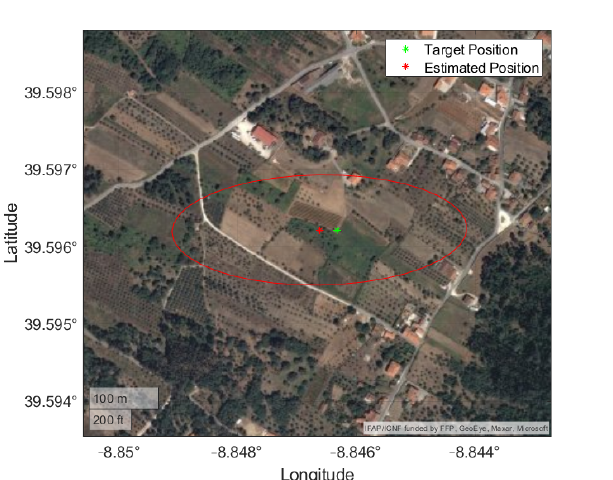
Figure 15. Mean position and uncertainty from ground perspective simulation displayed on a satellite view of the